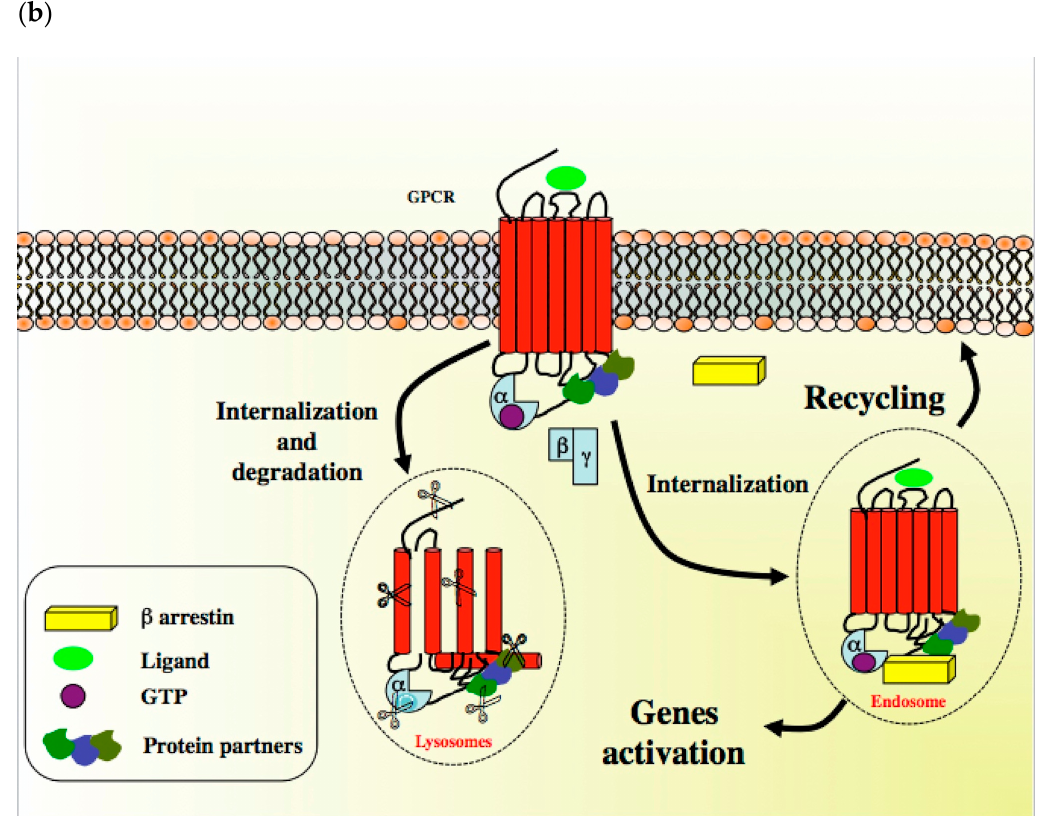
Scheme 1. Activation and trafficking process of a G protein-coupled receptor (GPCR). ( A ) When a GPCR is activated, GTP takes the place of GDP at the GPCR-coupled G protein α subunit,